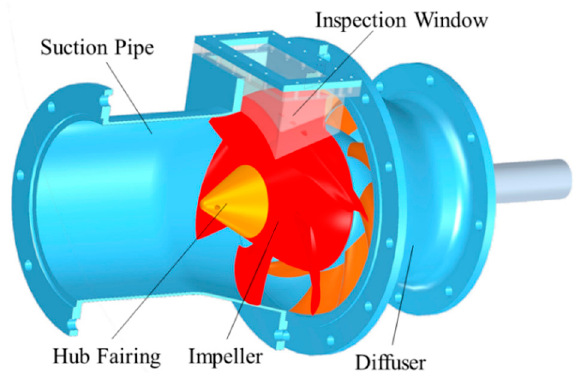
Figure 2. 3D model of the water-jet pump [3].